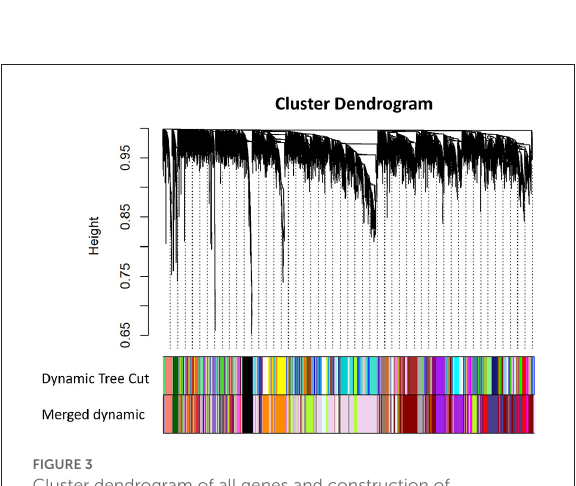
FIGURE3 Cluster dendrogram of all genes and construction of co-expression modules by WGCNA in GSE143272. Each branch represented one gene, and every color bar below corresponded to one co-expression module. All genes were finally divided into 24 different modules after merging modules with high similarity (WGCNA, weighted gene co-expression network